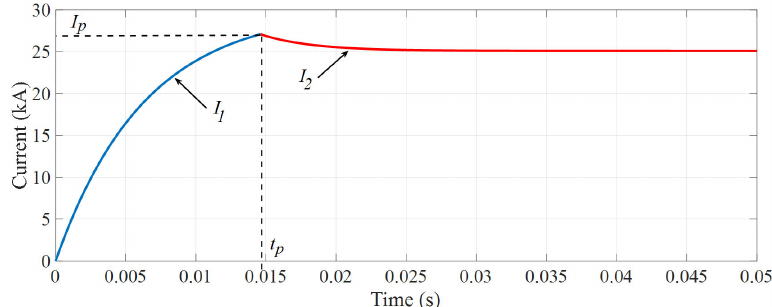
Figure 6. Fault current behavior of an AC generator based on Equation